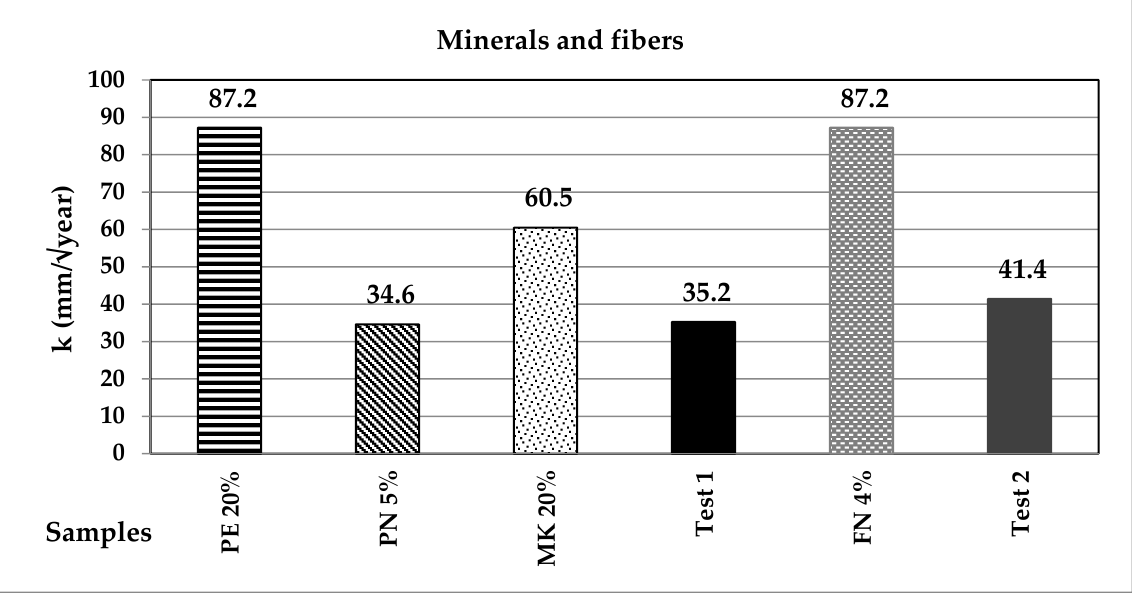
Figure 14. Constant k for the minerals and fibres group of additions. Figures 15 and 16 present the uniaxial compressive strength values of the analysed specimens; it is notable that the mixtures with higher k values and lower carbonation times also present lower mechanical resistances compared to the control samples. Two samples stand out from the rest: SBA and MK; they present higher mechanical properties while at the same time promote carbonation; in the case of SBA, it can be observed how the greater is the substitution percentage, the higher is the carbonation velocity and the lower is the mechanical resistance.